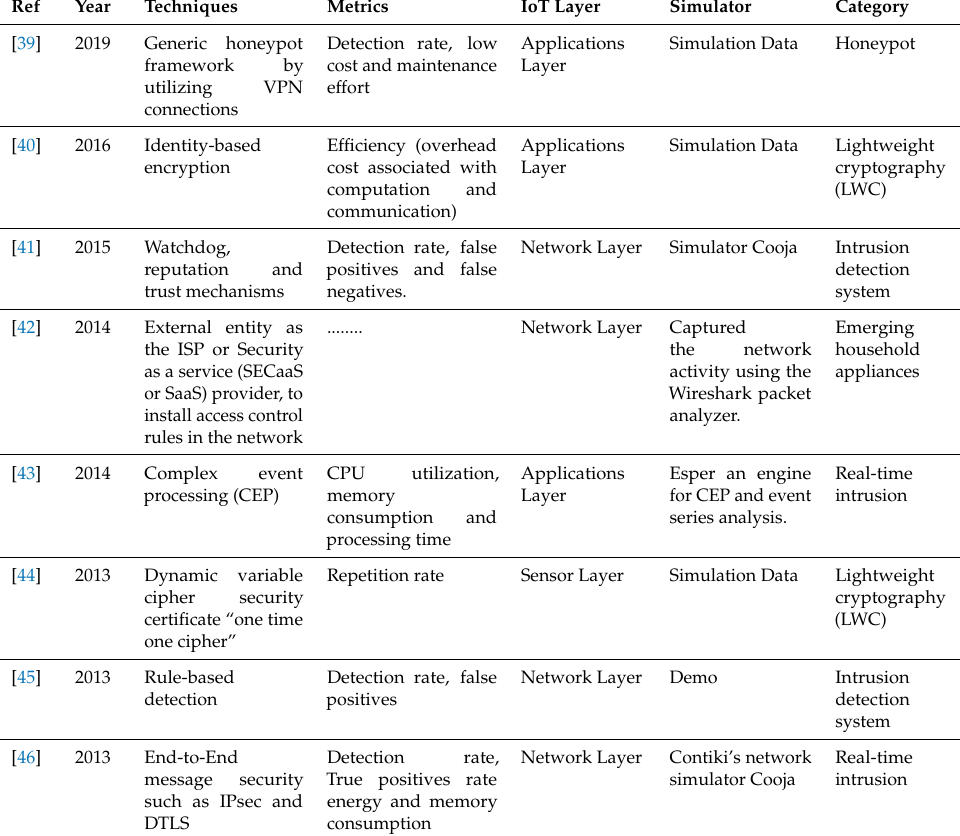
Table 1. Non-Artificial Intelligence-based Security